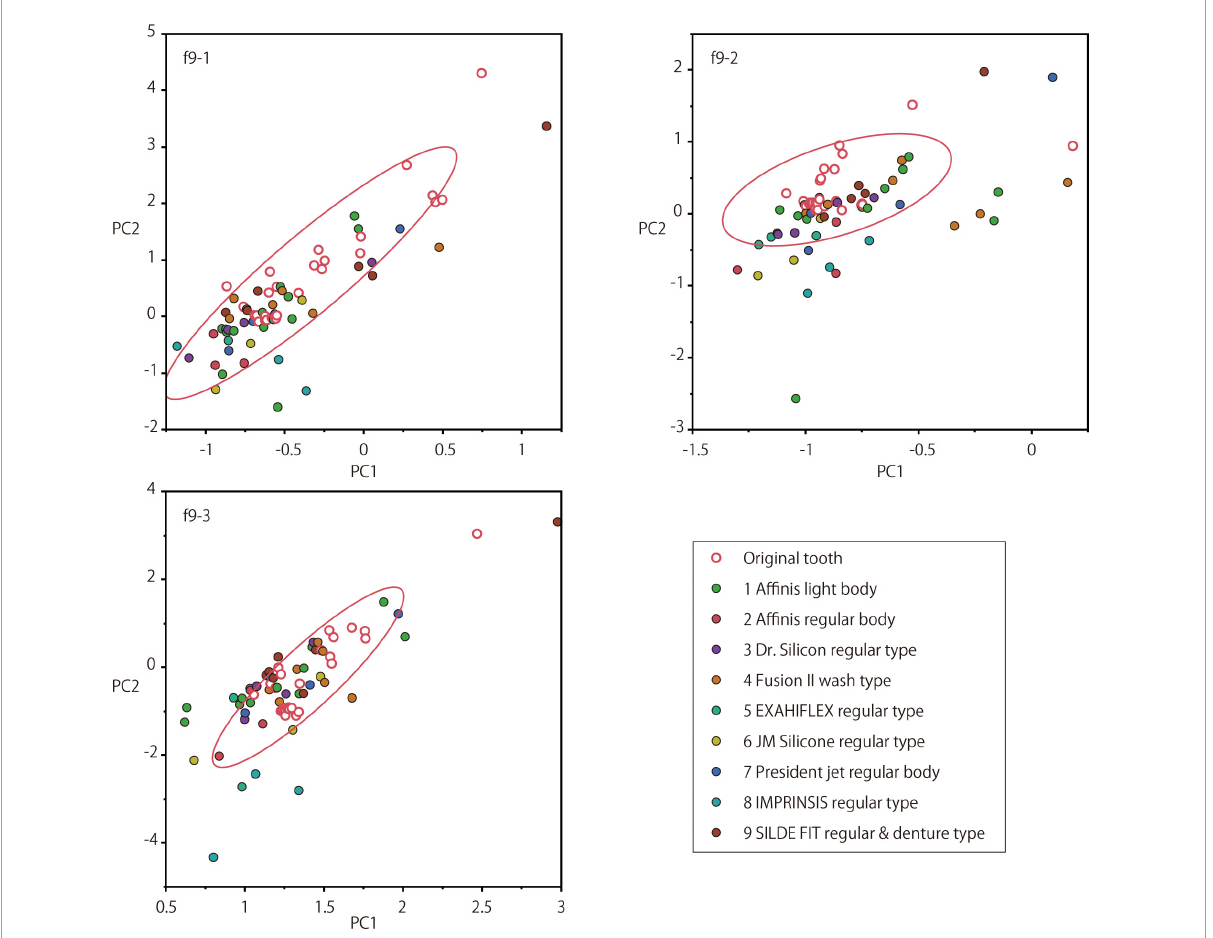
FIGURE4 Scatter plots of the PC scores obtained from 32 DMT parameters, presented respectively for each scan location on facet 9 (f9-1, f9-2, and f9-3). Variation of repeated scanning of the original tooth surface was presented by the ellipses, within which 90% of the data lie. Symbols for the dental impression materials are shown in right lower